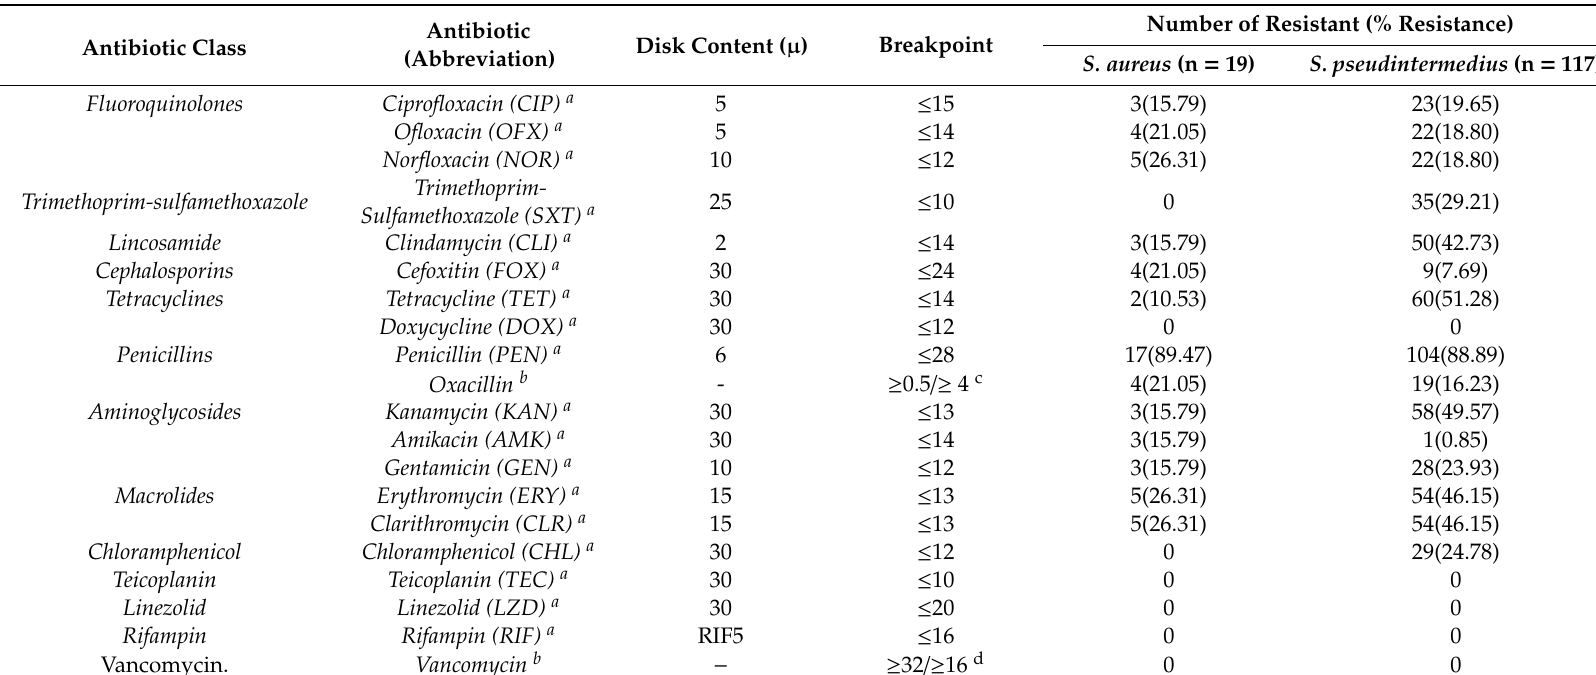
Table 2. Resistance frequency of 19 S. aureus and 117 S. pseudintermedius isolates recovered at the Complutense Veterinary Teaching Hospital (Spain) between 2006 and